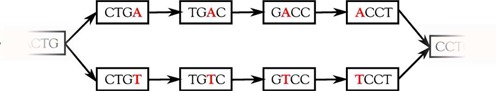
Toy example of a bubble in the de Bruijn Graph (k = 4). Bubble generated by a single nucleotide polymorphism. The two polymorphic sequences are …CTGACCT… and …CTGTCCT…